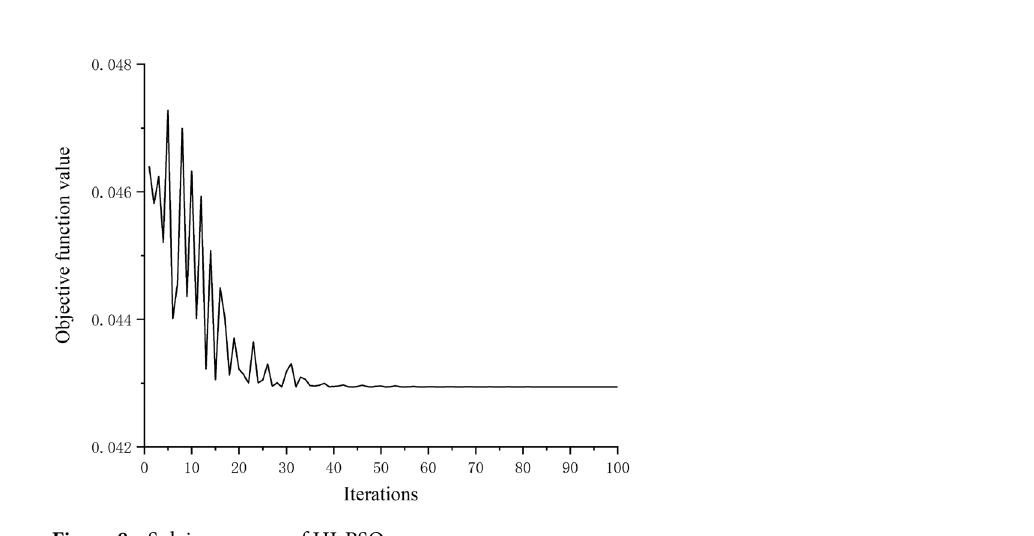
Figure 8. Solving process of